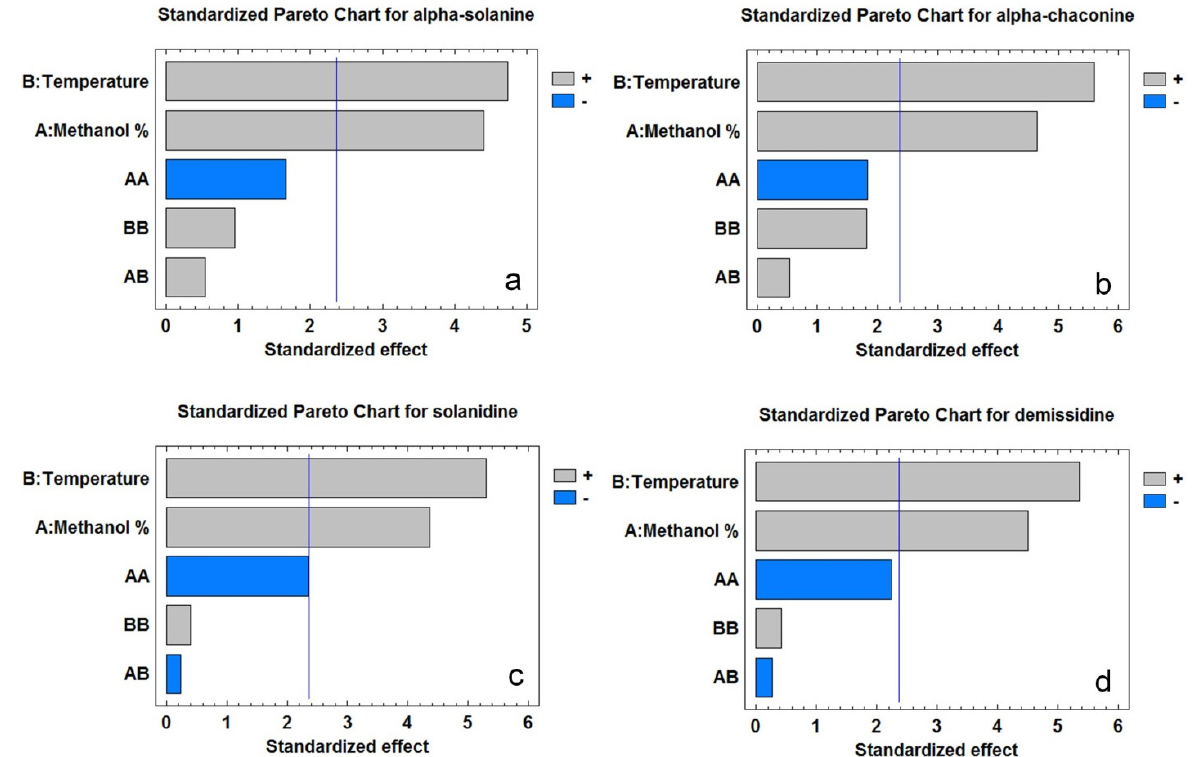
Figure 3. Standardised pareto charts of potato peel showing the effect of different factor terms (temperature and methanol concentration) on steroidal alkaloids such as α -solanine ( a ), α -chaconine ( b ), solanidine ( c ), and demissidine ( d ) contents in pressurized liquid extracts. Bars exceeding the vertical line on the graph indicate that the corresponding factor terms are significant ( p <